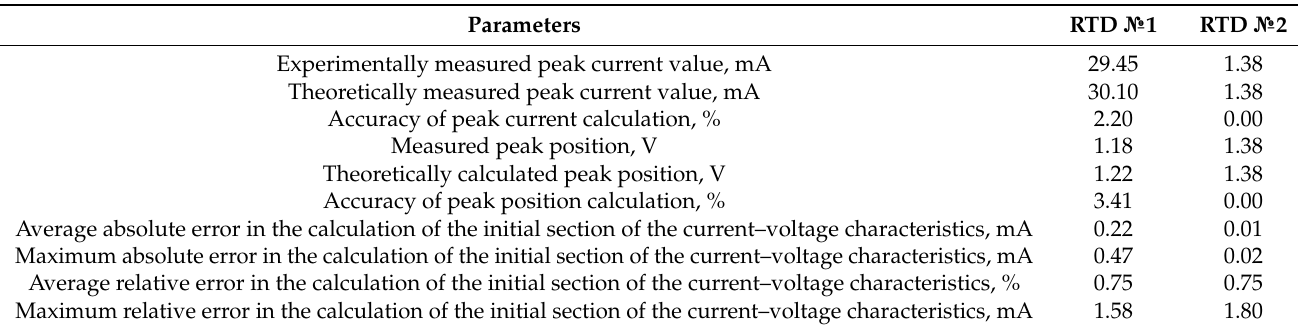
Table 1. Experimental and simulated RTD parameters.